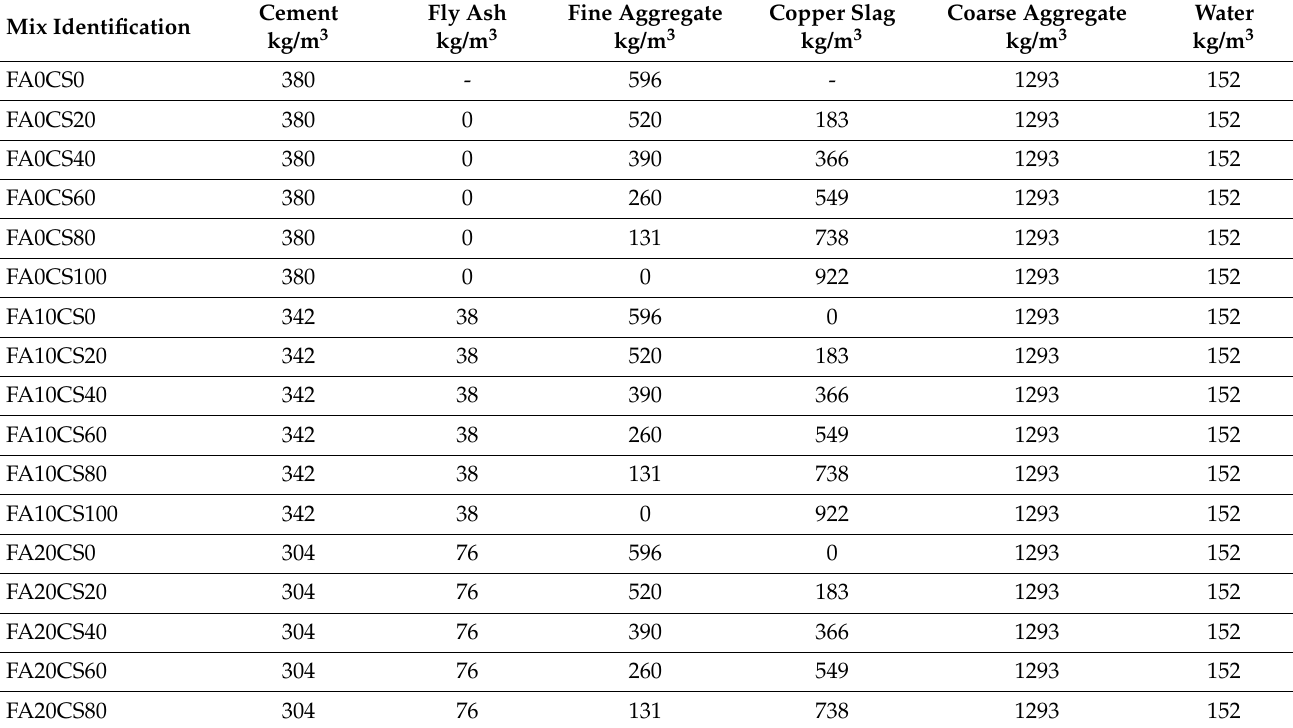
Table 5. Mix composition of M310 grade of